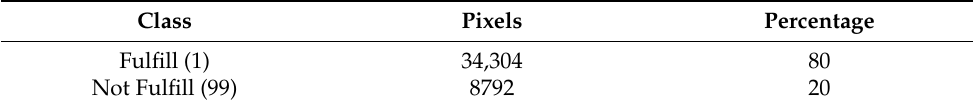
Table 2. Distribution among classes of the ground-truth